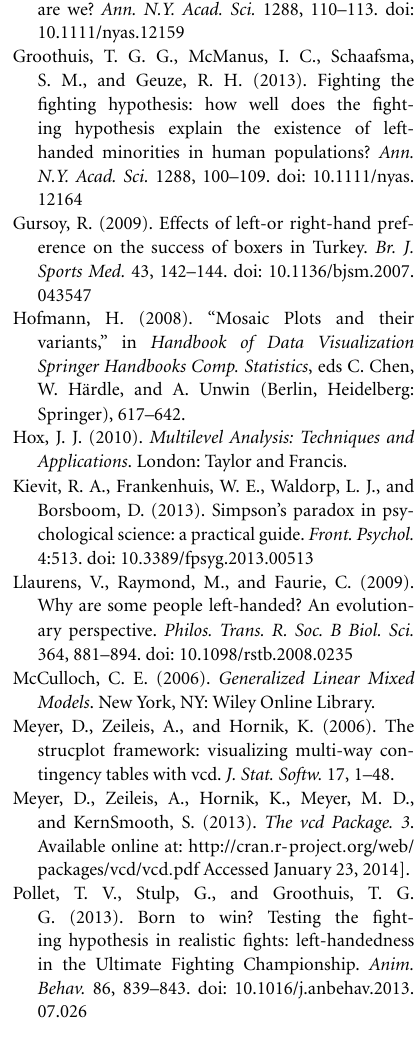
does affect outcomes (e.g., Wrestling